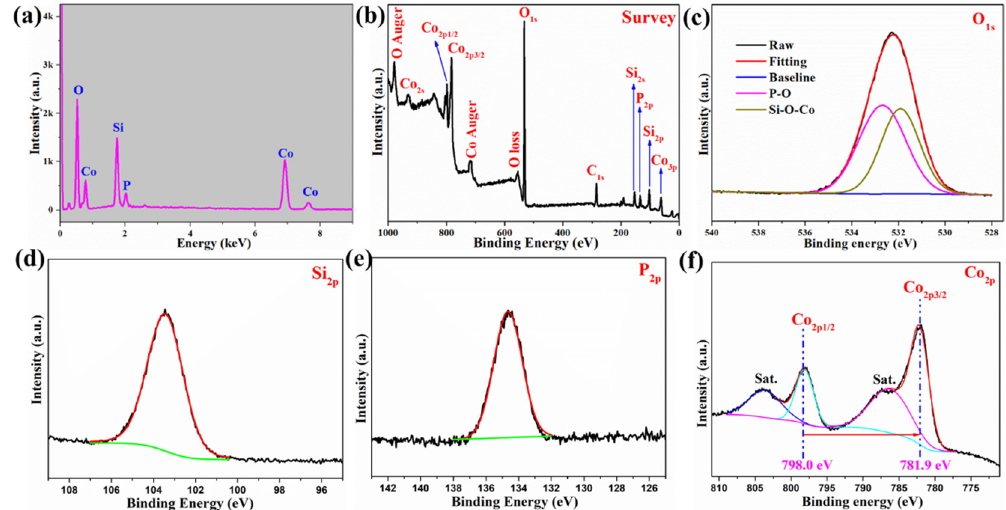
Figure 2. ( a ) The EDS spectrum of PCoSi; ( b – f ) XPS spectra of PCoSi: ( b ) full-level spectrum; ( c ) O1s core-level spectrum; ( d ) Si2p core-level spectrum; ( e ) P2p core-level spectrum; ( f ) Co2p core-level spectrum.